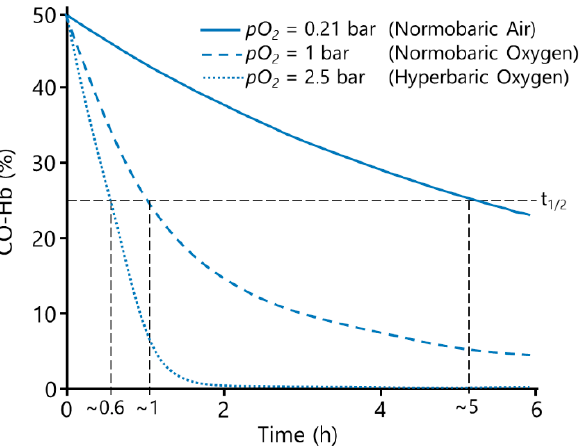
Figure 1. Influence of O 2 partial pressure on CO-Hb-level decrease, determined from [5,9]. Pharmacological treatment options that are currently being investigated include the use of a combination of hydroxocobalamin and ascorbic acid into a reduced form [16], a supramolecular complex (hemoCD) [17], and molecules based on bioengineered neu- roglobin [18,19]. These drugs have shown a great affinity for CO and are used as scavenger molecules to eliminate carbon